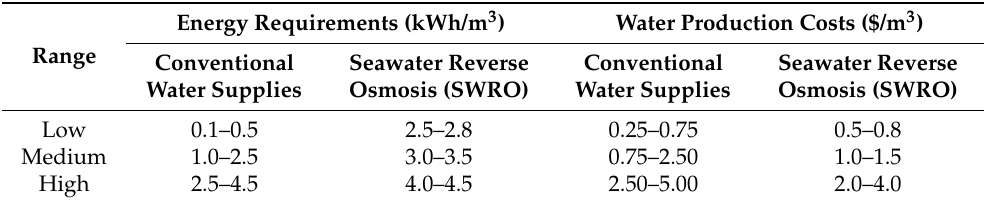
Table 4. Comparison of water costs for conventional and desalination water supply options (Voutchkov, 2011, 2014; Plappally, 2012) as cited by [26]. Energy Requirements (kWh/m 3 Range